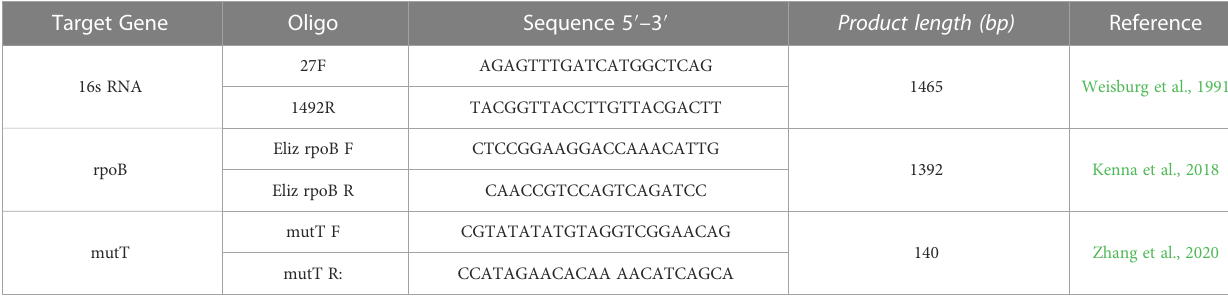
TABLE 1 Sequence of the oligonucleotide primers used for PCR ampli fi cations in this study. Target